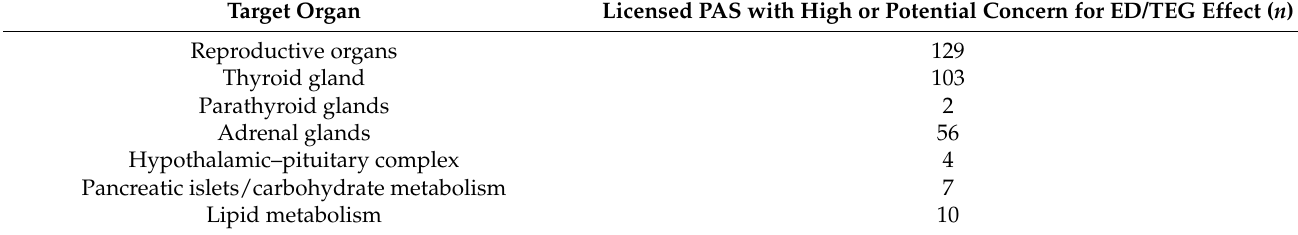
Table 3. Number of phytopharmaceutical active substances (PAS) with a product license in 2018 in France identified with a high or potential concern for disruptor or toxic effect (ED/TEG) by target organ.